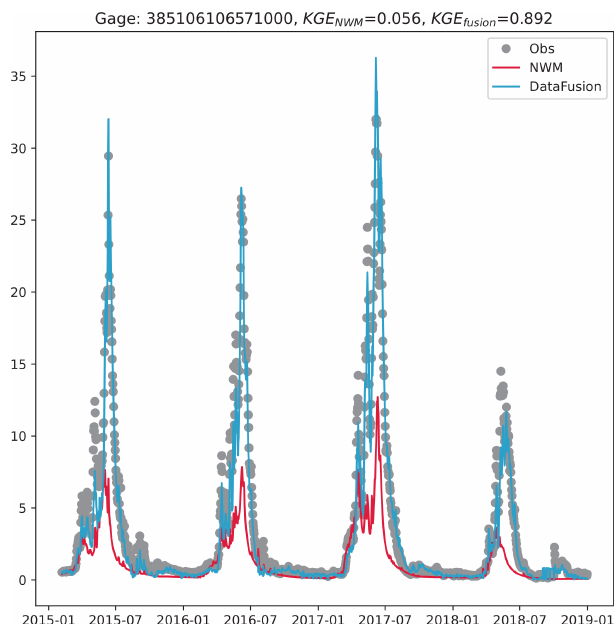
Figure 10. The effect of data fusion is validated on Gage 385106106571000 which is not used in any ML training and resid- ual propagation. The KGE is improved from 0.056 to